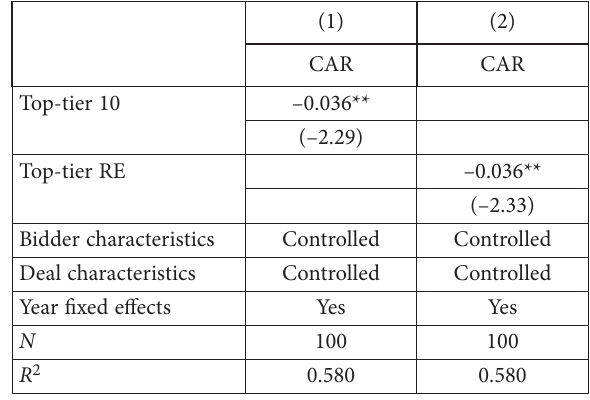
Table 6. Cross-sectional regression analysis of bidder CARs with alternative financial advisor